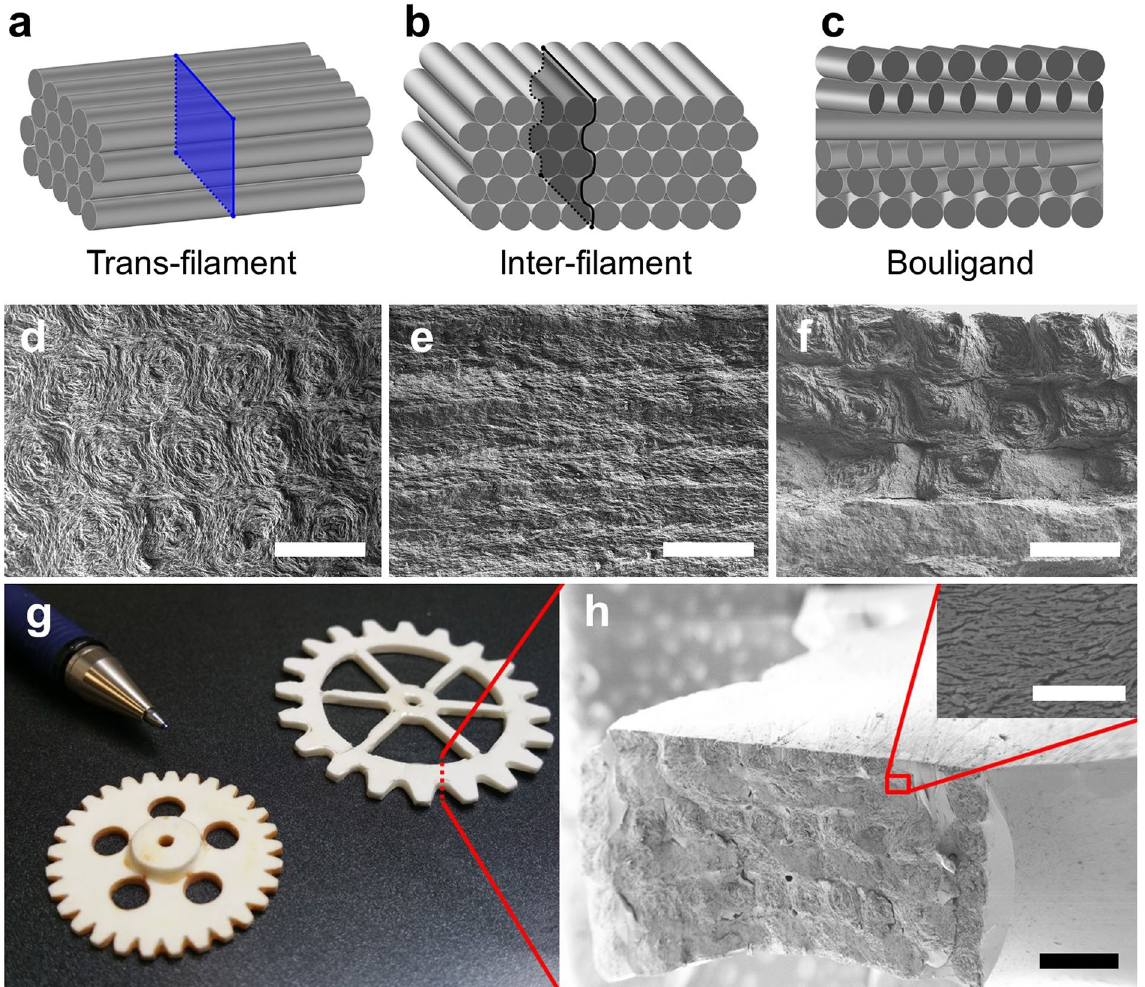
Figure 2. Microstructures of bioinspired platelet-epoxy composites produced via robocasting of platelet pastes and comparison to natural analogues. ( a , b , c ) Schematic diagrams of the three morphologies (trans-filament, inter-filament and Bouligand) produced by controlling the printing direction, with fracture direction indicated. ( d , e , f ) SEM images of fracture surfaces of the three composites, infiltrated with epoxy. Scale bars 400 μ m. ( g ) Photograph of composite parts produced from arbitrary CAD files to demonstrate the flexibility of the technique. ( h ) SEM images showing the microstructure of the printed part. Scale bars 10 and 500 μ